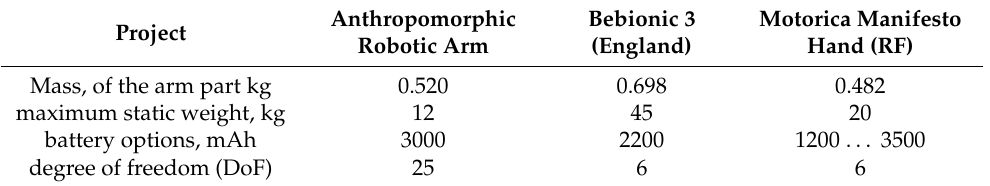
Table 2. The comparison of the mass and size parameters of anthropomorphic robotic arms